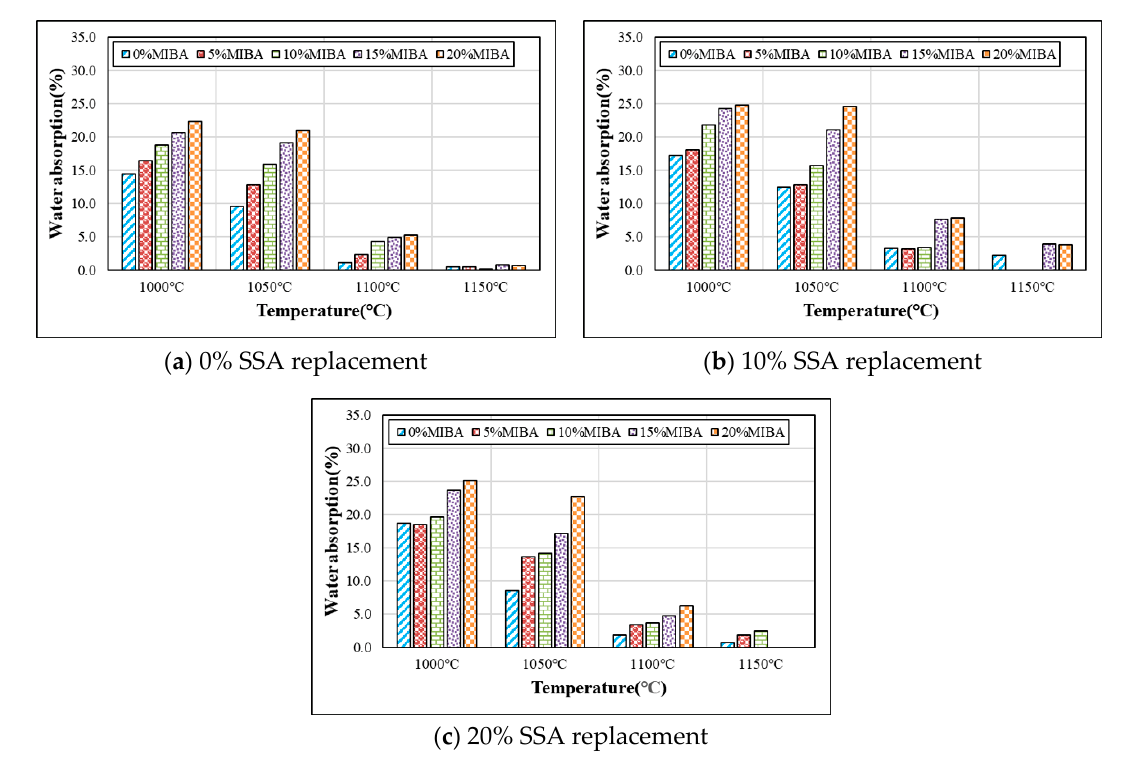
Figure 7. Results of the water absorption tests. ( a ) 0% SSA; ( b ) 10% SSA; ( c ) 20% SSA.